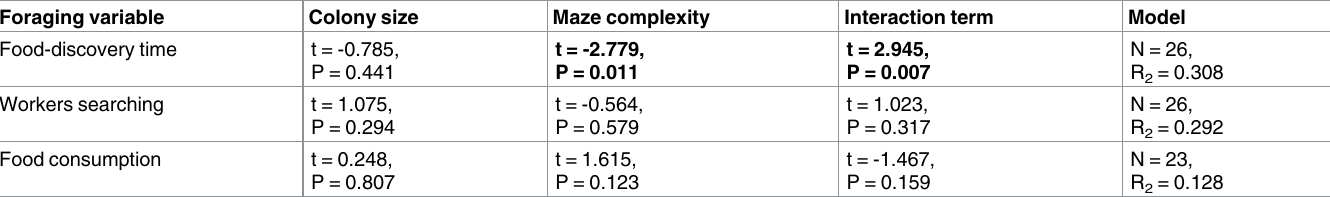
Table 1. The effect of colony size and maze complexity on the three foraging response variables on the first day and test. Foraging variable Colony size Maze complexity Interaction term Model Food-discovery time Workers searching Food